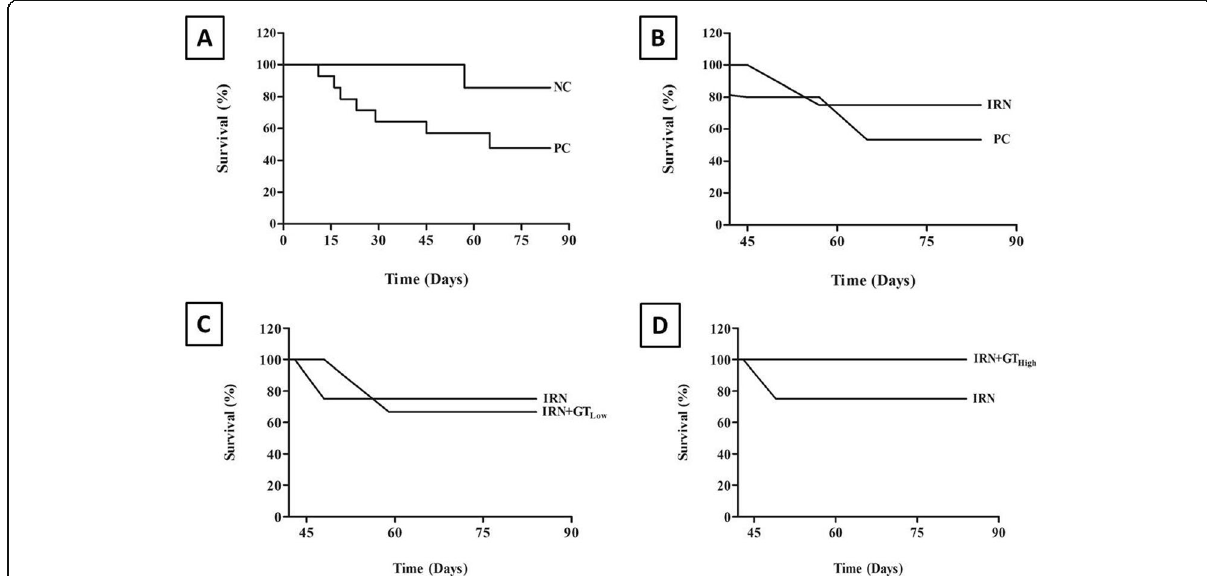
Fig. 3 Effect of IRN and GT on survival percentage during the 12-week treatment period. Values were presented as mean ± SEM, # p < 0.05, ## p < 0.01, and ### p < 0.01 when compared to the PC group and * p < 0.05, ** p < 0.01, and *** p < 0.001 when compared to the IRN group. Significant increase in survival percentage was recorded in the IRN group when compared to the PC group. Survival percentage was recorded to be higher in the IRN+GT